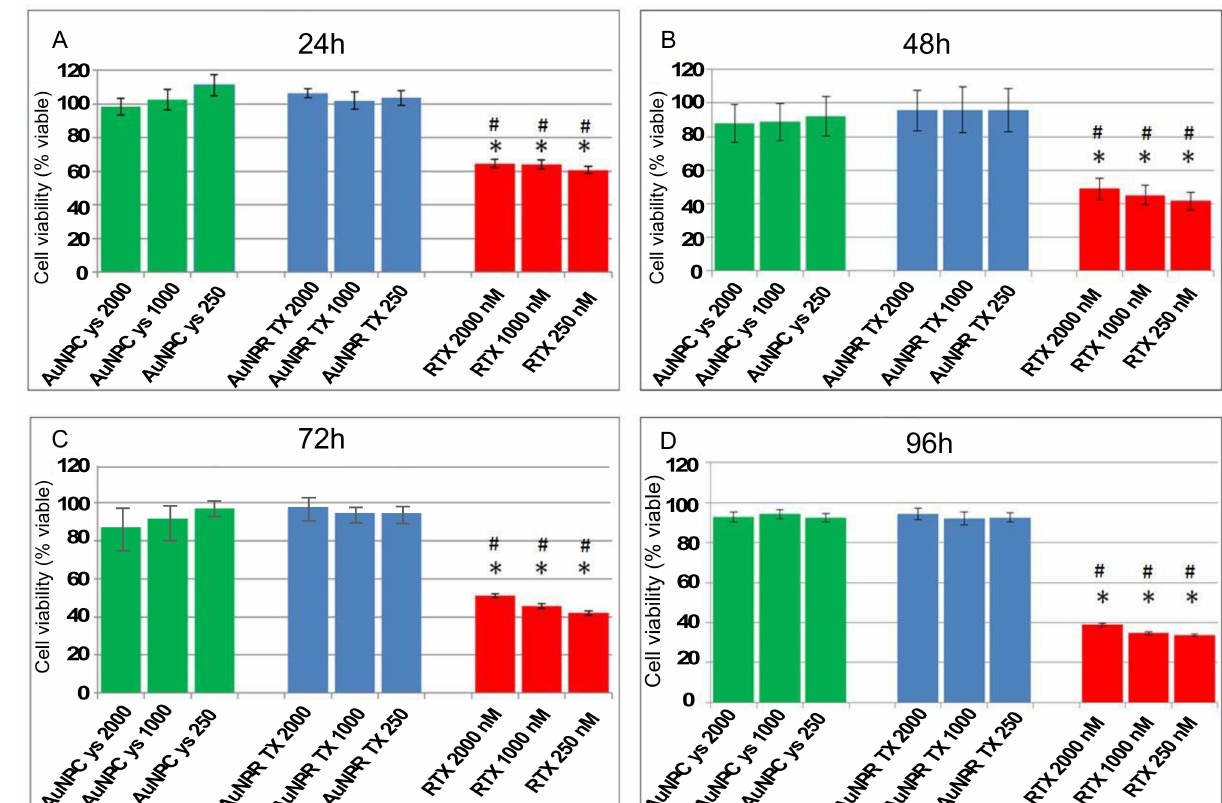
Figure 2. Behavior of the HCT116 cells after treatment with AuNP-Cys (green bar), AuNP-Cys-RTX (blue bar), and RTX (red bar) at different concentrations and time periods ( A ) 24 h, ( B ) 48 h, ( C ) 72 h, ( D ) 96 h. The nanoparticle (NP) concentrations are expressed as nM of RTX. Each bar represents the mean +/ − SEM of three independent experiments performed in triplicate and normalized to non-treated cells (taken as 100%). The asterisk (*) and the hash mark (#) indicate significant differences between the viability resulting from treatment with “free” RTX and the equivalent concentrations of AuNP-Cys and AuNP-Cys-RTX, respectively ( p -Value <